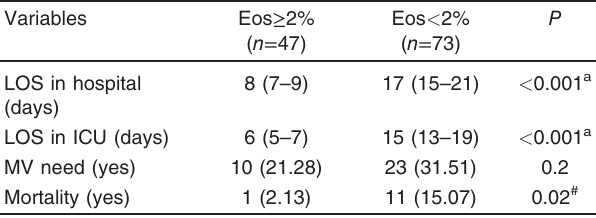
Table 2 Patient outcomes in correlation with their eosinophil